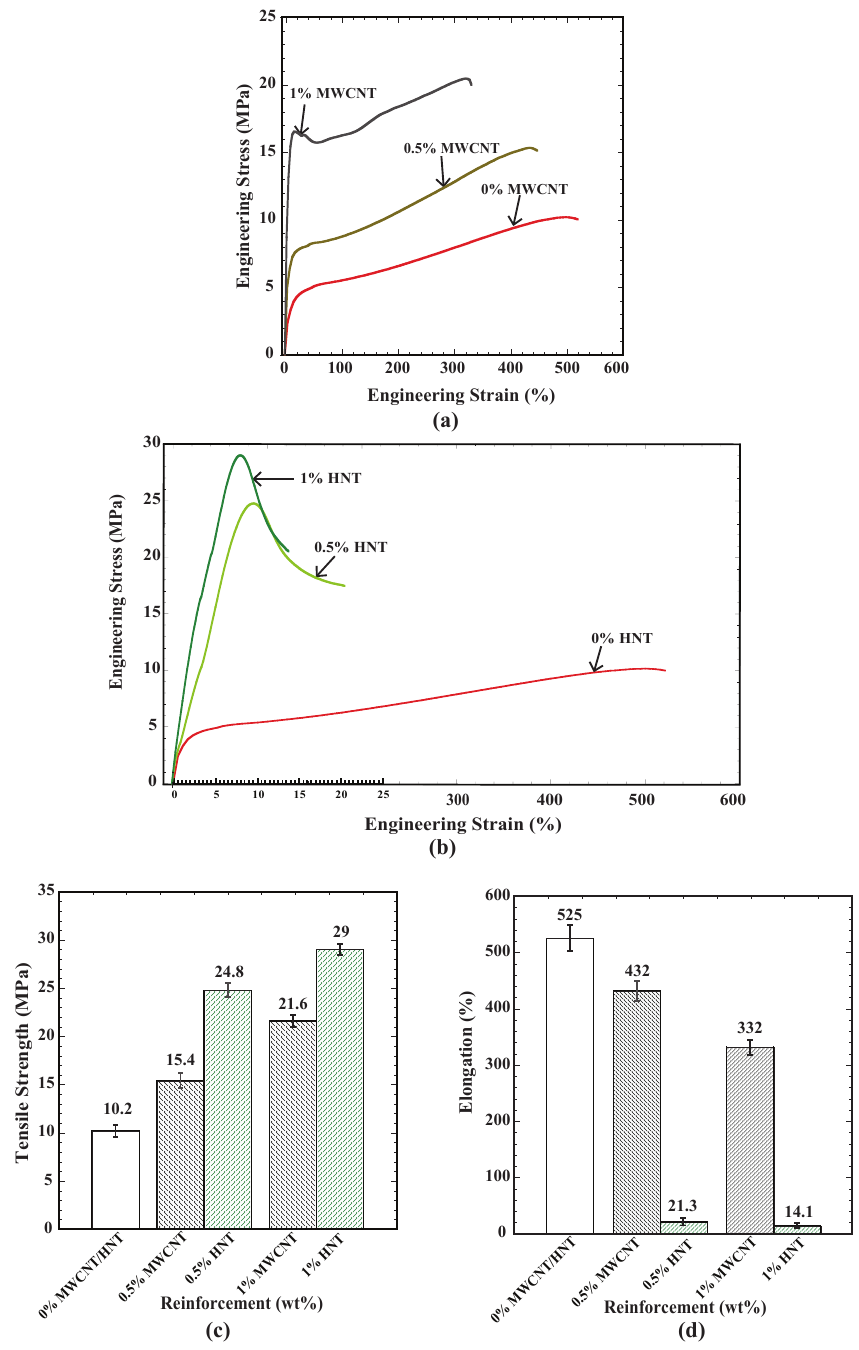
Figure 5. ( a ) Engineering stress vs. strain (%) for SMPU with various wt% of MWCNTs; ( b ) engineer- ing stress vs. strain (%) for SMPU with various wt% of HNTs; ( c ) tensile strength vs. reinforcement % for all specimens; ( d ) Percentage of elongation for all